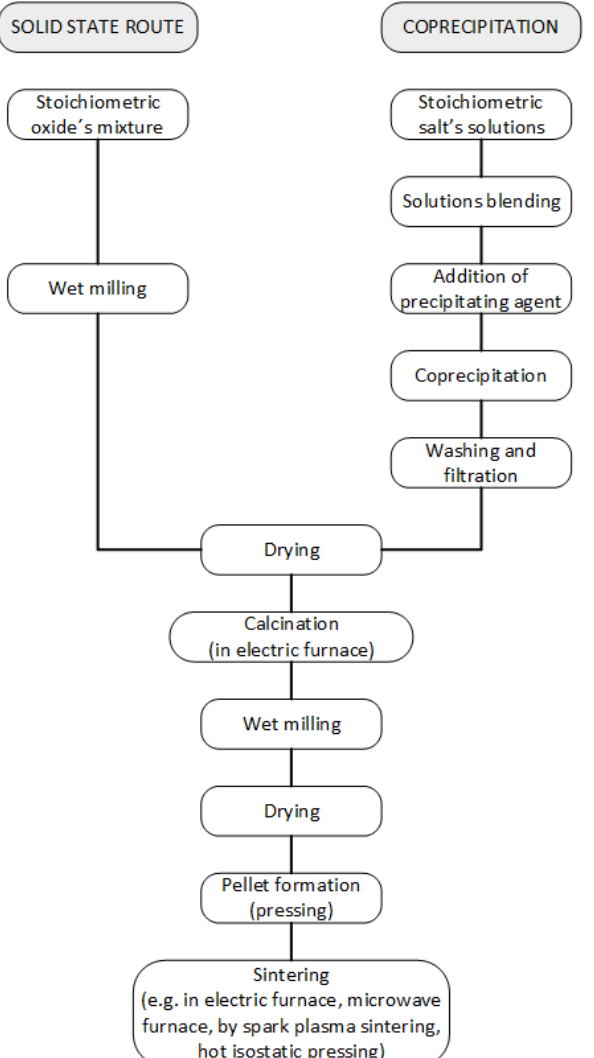
Figure 3. Flux diagram of the conventional route for processing piezoelectric ceramics and alternative coprecipitation route.